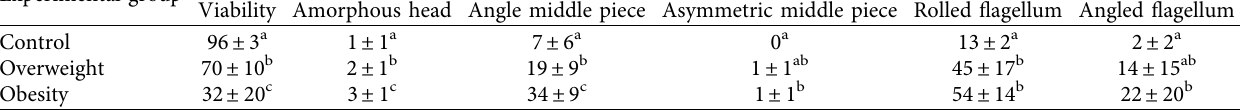
Experimental group